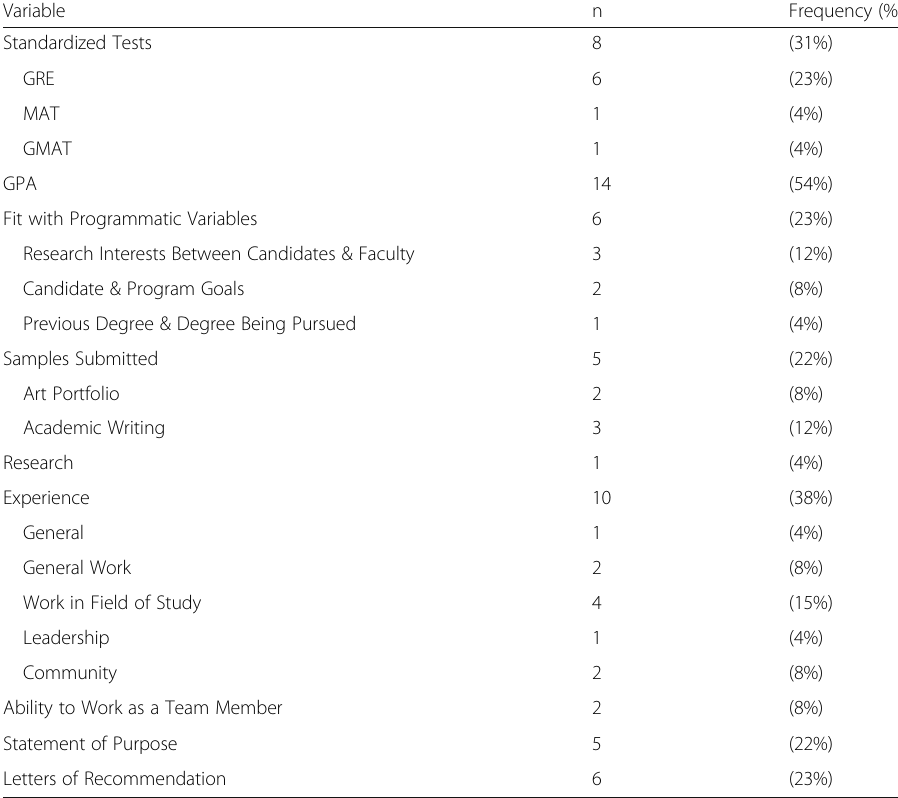
Table 3 Additional criteria identified through qualitative analysis Variable